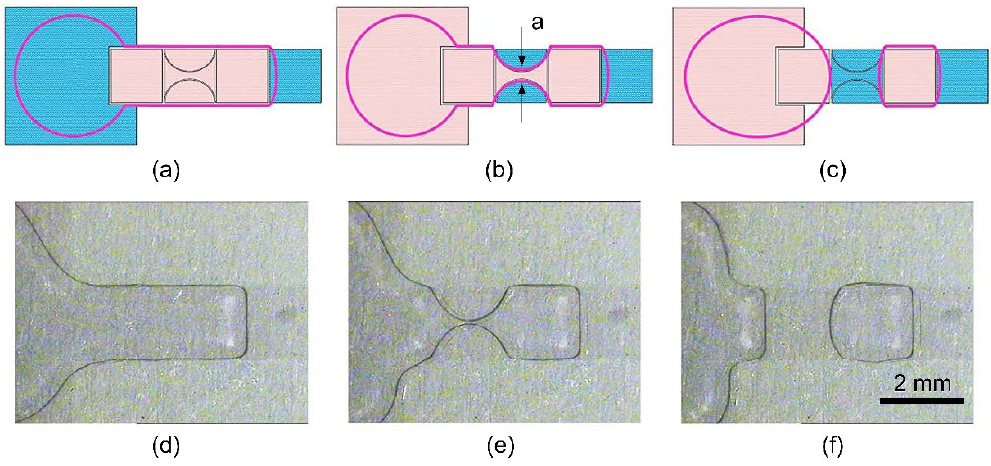
Figure 4. Schematics and photos of EWOD dispensing process with dumbbell-shaped electrode design (top view). ( a – c ) Schematic of the dispensing process. The pink electrodes are applied to the driving voltage with blue ones applied to the ground, and the purple circular contour indicates deionized water (DI water). a is the width of the finest point in the center dumbbell (denoted as neck width). ( d – f ) Photos of extrusion, necking, and breaking step, respectively.